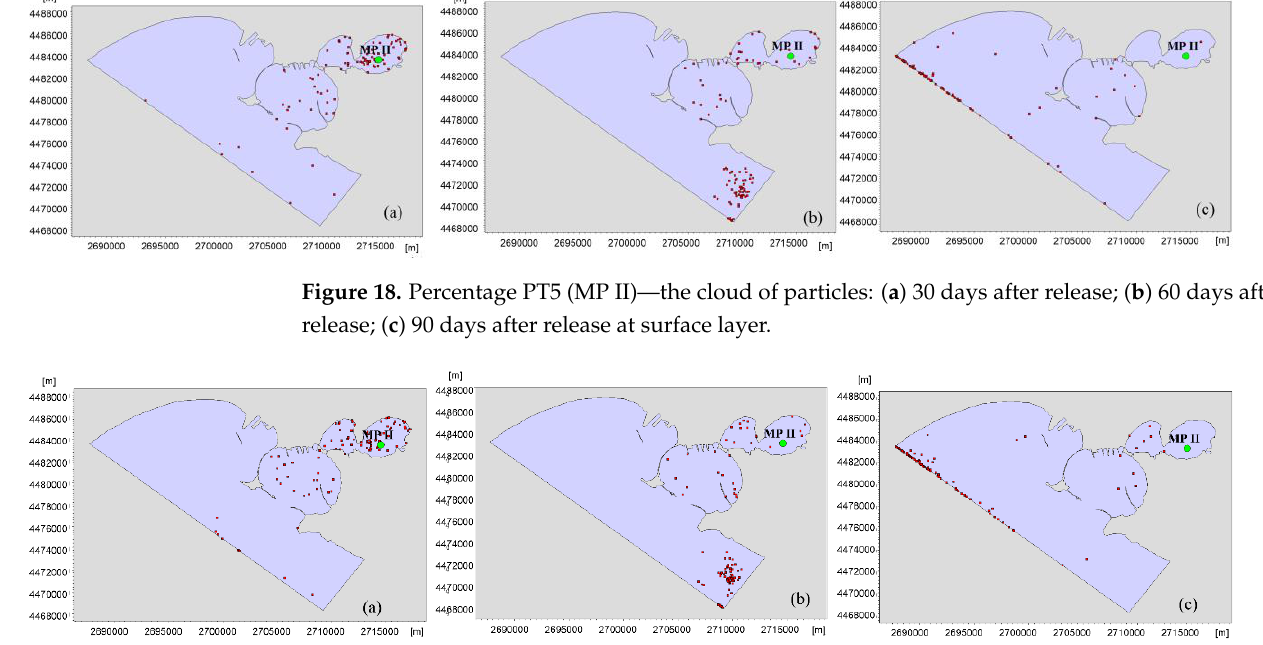
Figure 19. Percentage PT5 (MP II) — the cloud of particles: ( a ) 30 days after release; ( b ) 60 days after release; ( c ) 90 days after release at bottom layer.